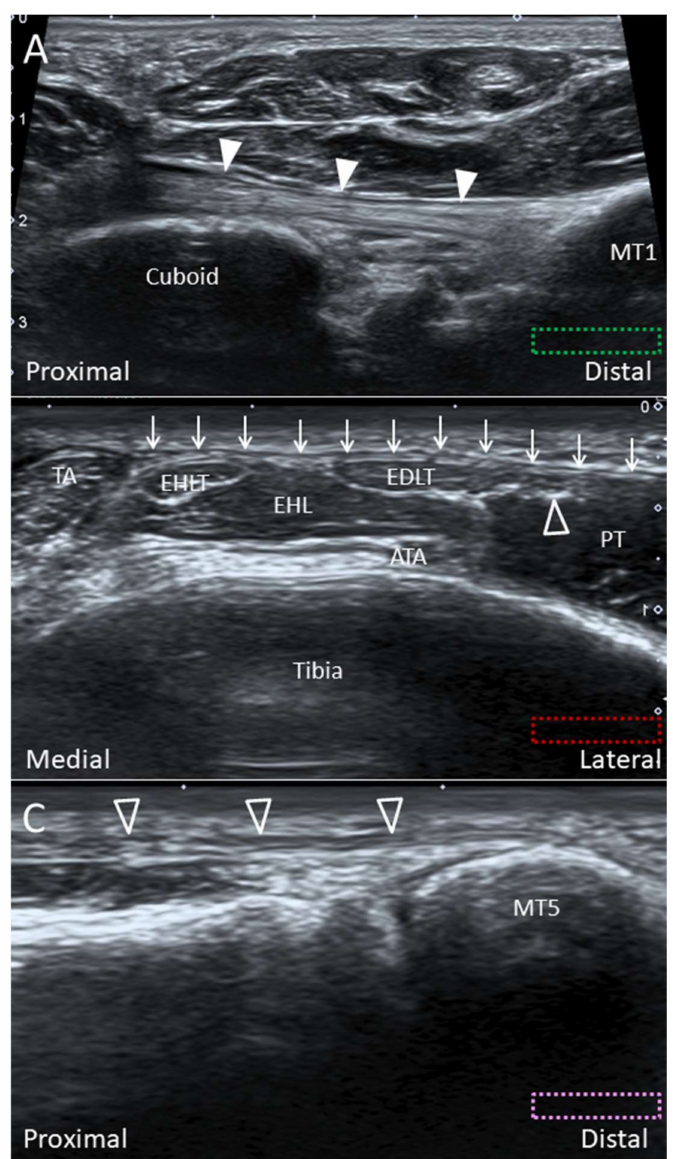
Figure 20. Imaging of the peroneus longus tendon (white arrowheads) in the long axis at the distal insertion ( A ), the peroneus tertius tendon (void arrowhead) in short axis at the distal tibia level ( B ) , and in long axis at the distal insertion ( C ). The colored dashed rectangles are in accordance with the transducer positions in Figure 3B,C. Arrows: superior extensor retinaculum; ATA: anterior tibial artery; EHL: extensor hallucis longus muscle; EHLT: extensor hallucis longus tendon; FDLT: flexor digitorum longus tendon; MT: metatarsal bone; PT: peroneus tertius muscle; TA: tibialis anterior